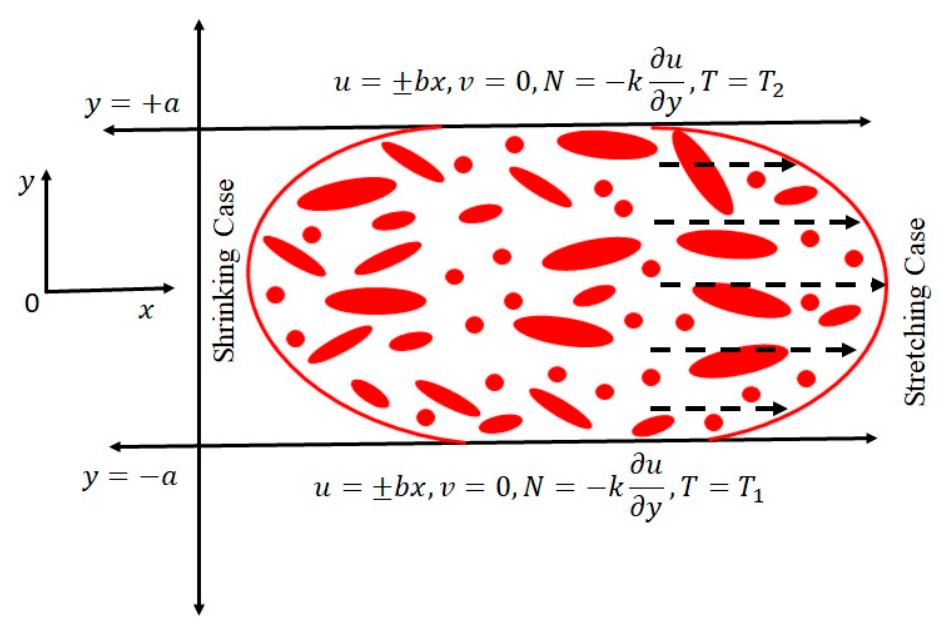
Figure 1. Physical sketch of the problem.